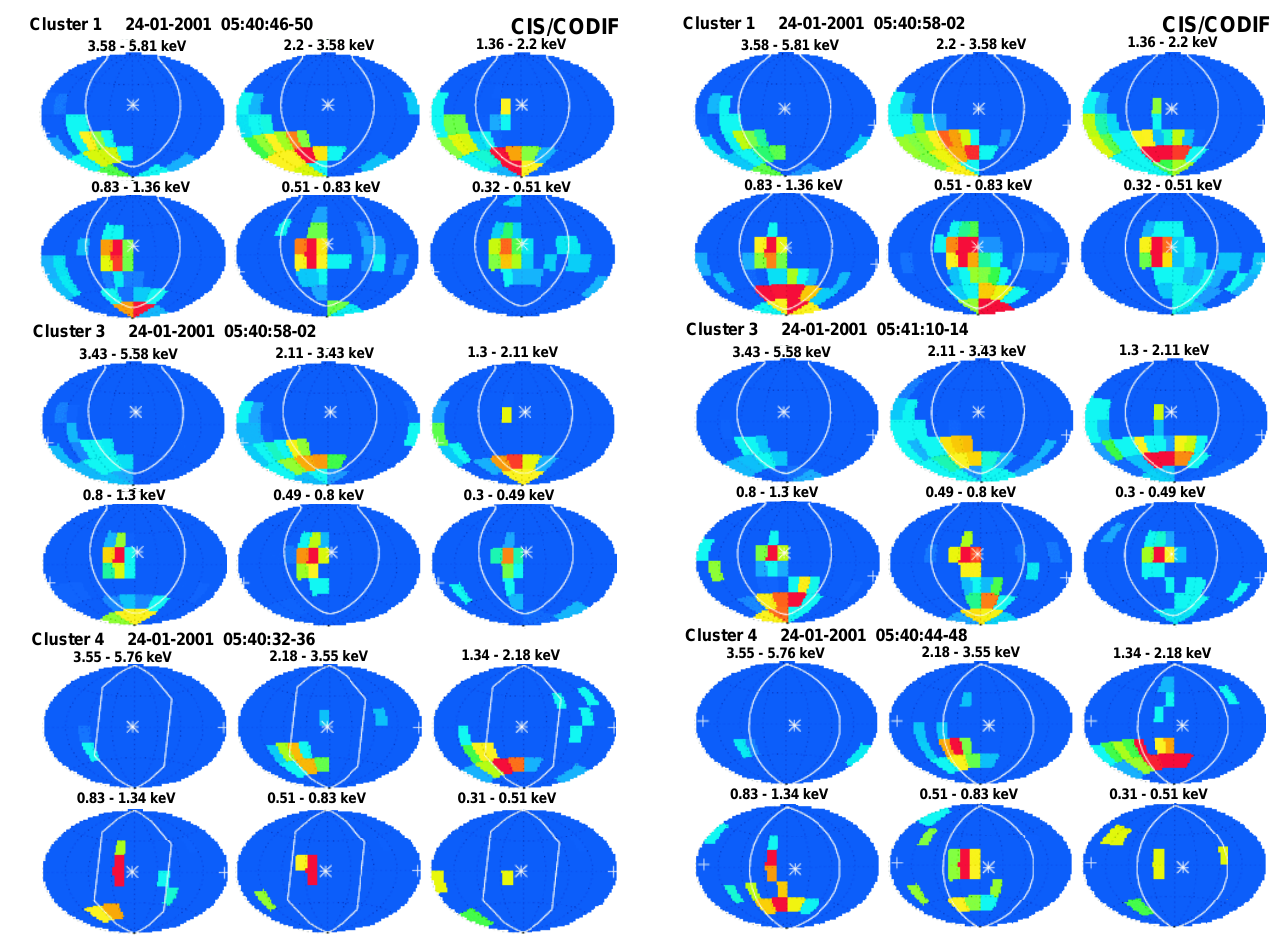
Fig. 3b. Similar representation as Fig. 3a exactly at the edge of the shock ramp. The fact that no counts are seen in the pole pixels at the bottom for spacecraft 4 is due to the fact that the corresponding angle range is blind at both poles on the low sensitivity side in order to prevent spillover from the high sensitivity side of the sensor.